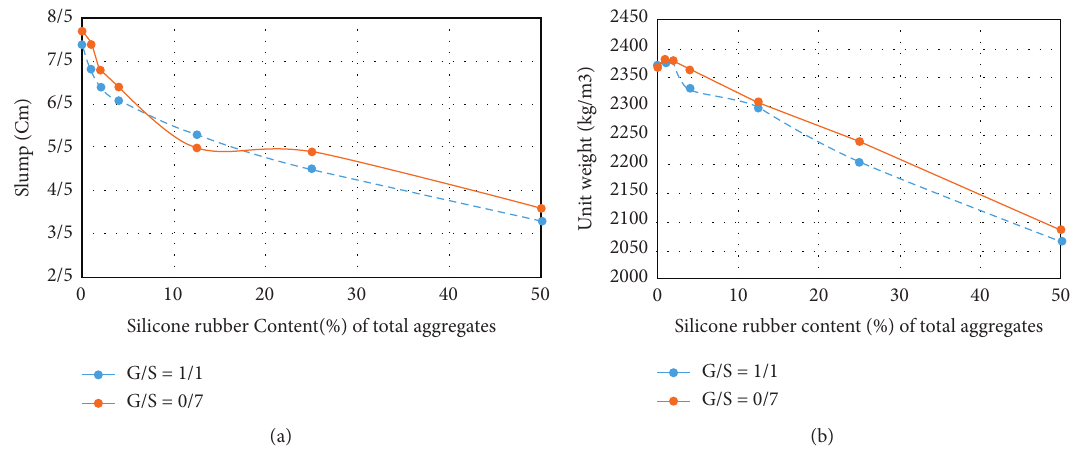
Figure 3: Properties of fresh HSRC. (a) Slump. (b) Unit weight of fresh